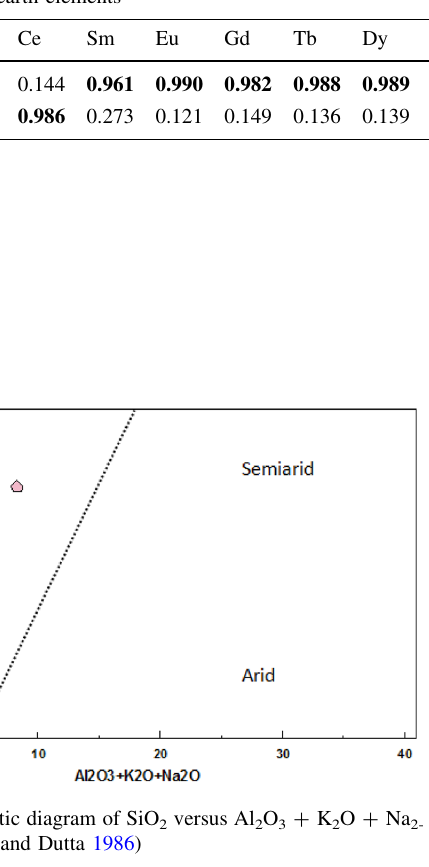
Fig. 9 Rare earth element cluster analysis Table 8 Varimax rotated component matrix of rare earth elements Component Rare earth elements Eigen